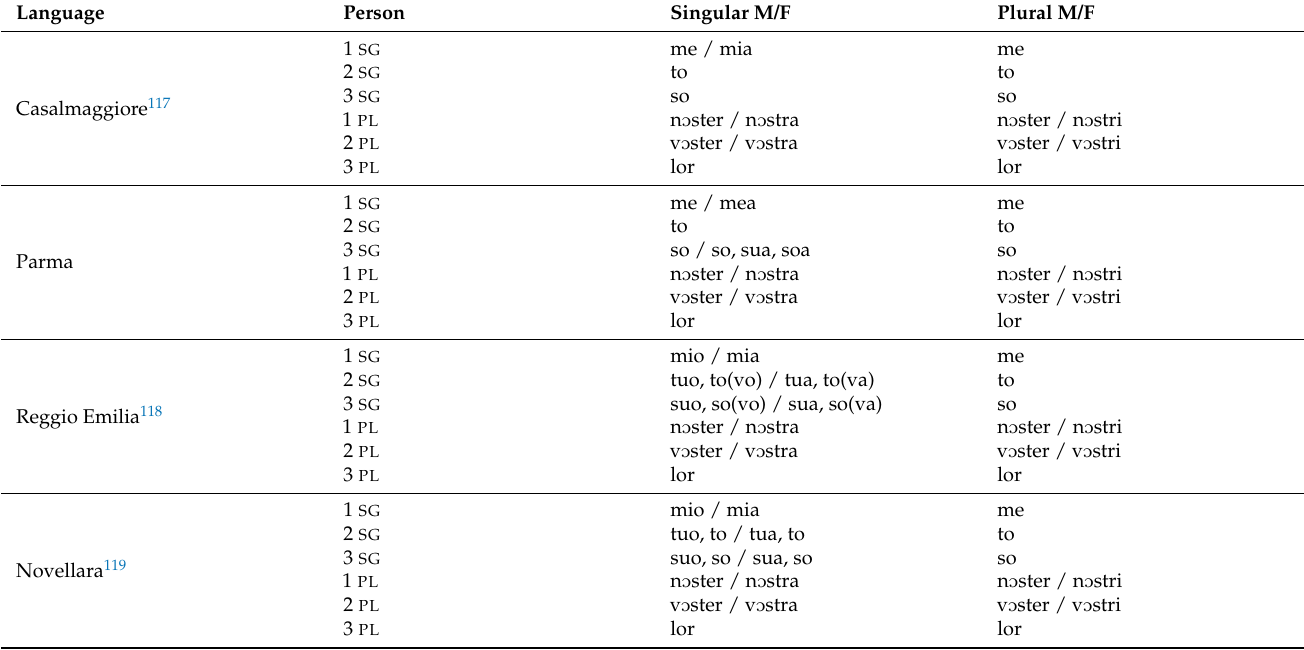
Table A3. Pronominal possessives.